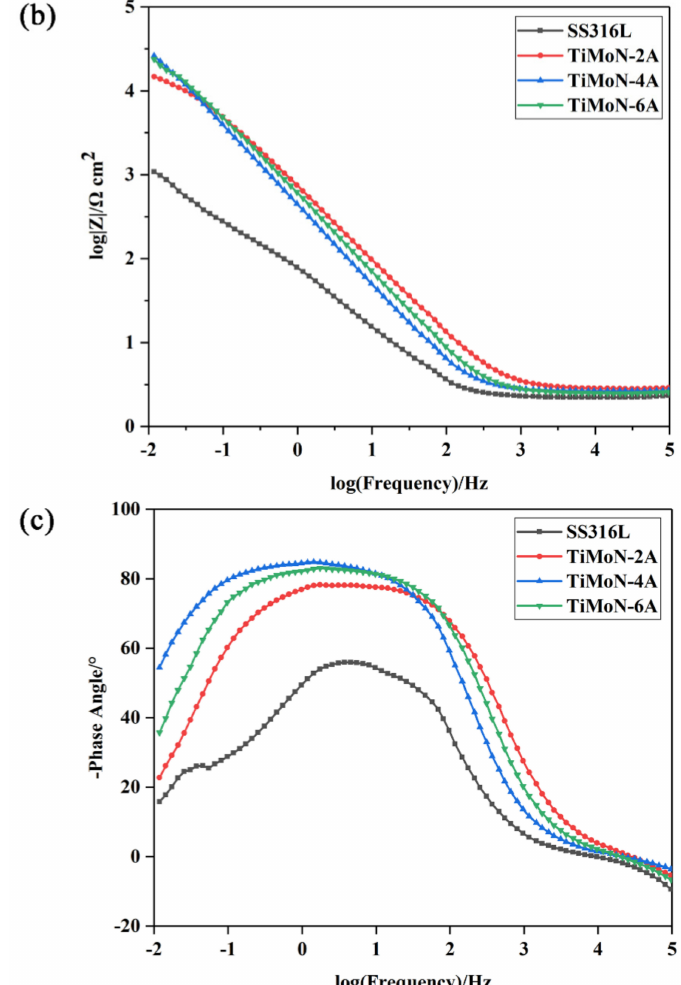
Figure 8. EIS curves of SS316L and TiMoN coatings: ( a ) Nyquist plots, ( b ) |Z| plots, ( c ) phase angle